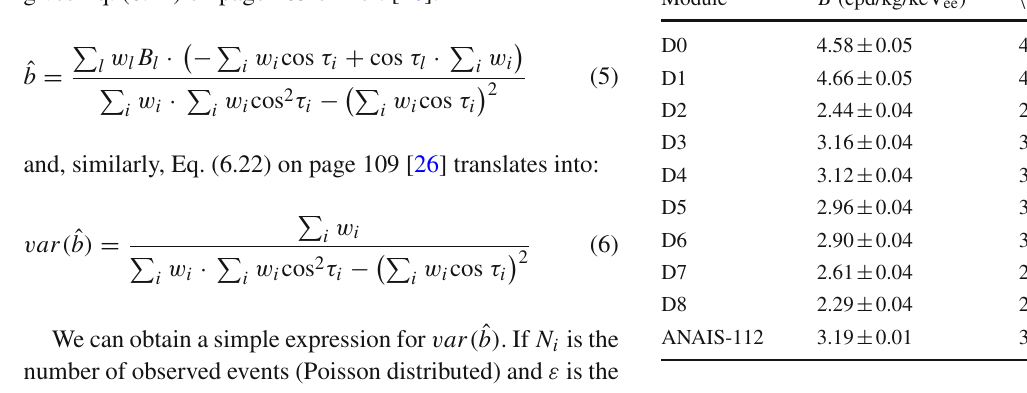
Table 1 Measured ∼ 10% unblinded background (Fig. 3) in the [2,6] keV ee energy interval for all modules after filtering and efficiency cor- rection(Fig.1)havebeenapplied(2ndcolumn).Consideringtheenergy binning, the relevant quantity is (cid:9) B /ε (cid:10) (3rd column), where the back- ground is divided twice by the efficiency, see Sect. 3.1.2. The average values for ANAIS-112 are listed in the last row Module